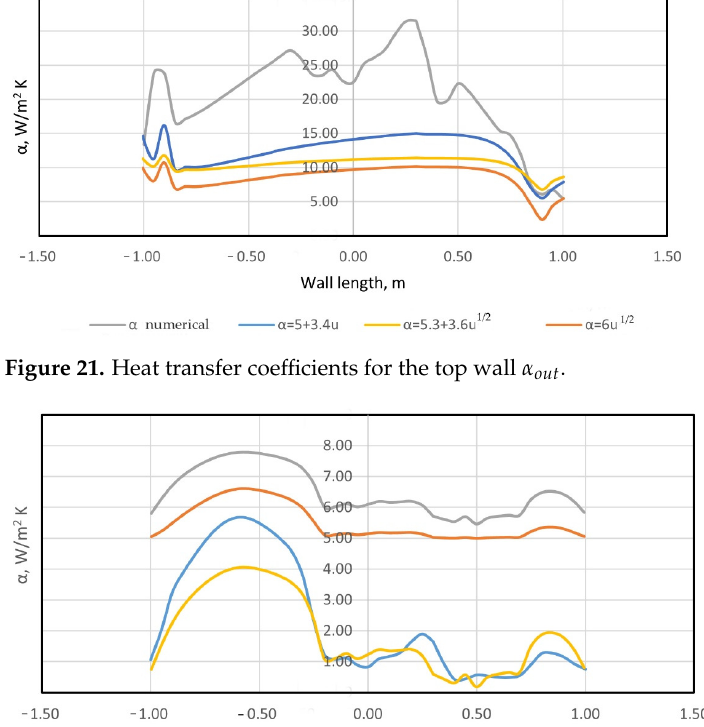
Figure 22. Heat transfer coefficients for the top wall α in .